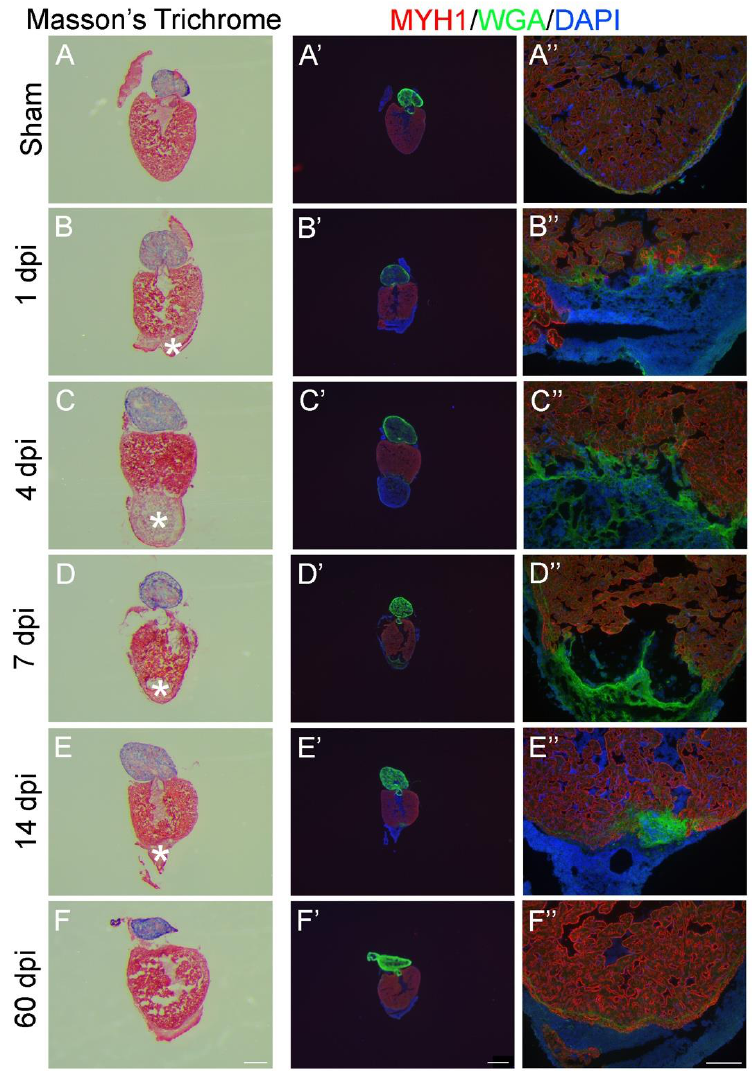
Figure 3. Evaluation of zebrafish heart regeneration in 2D-analysis using histology and immunoflu- orescence. Cryosections from either sham operated ( A , A’ , A’’ ) or apex resected ( B – F , B’–F’ , B’ ’– F’’ ). Zebrafish hearts were stained with Masson’s Trichrome (A–F) or immunostained with anti-MYH1 against myosin heavy chain (MYH1, red), wheat germ agglutinin (WGA, green) and 4’,6´-dia- midino-2-phenylindole (DAPI, blue) ( A’ – F’ and A’’ – F’’ ). Five timepoints (dpi: days post injury) after apex resection were investigated: 1 dpi ( B , B’ , B’ ’), 4 dpi ( C , C’ , C’’ ), 7 dpi ( D , D’ , D’’ ), 14 dpi ( E , E’ , E’’ ) and 60 dpi ( F , F’ , F’’ ). * marks fibrin clot. Scalebars: A–F = 300 µm, A’–F’ = 500 µm and A’’–F’’ = 100 µm.